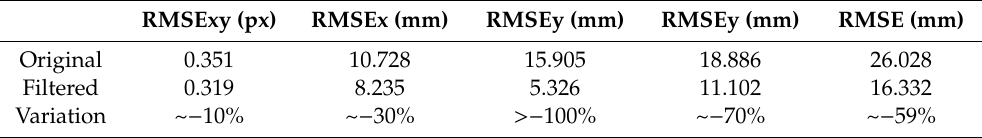
Table 10. Check-point RMSEs in the original and filtered sparse point cloud and variation of the obtained